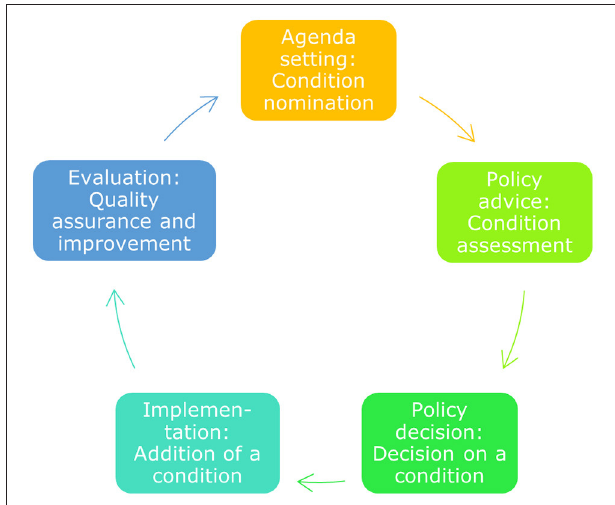
FIGURE 1 | The public health policy cycle. The public health policy cycle consists of five phases. These five phases translate to specific activities for NBS, from nomination of a condition to its quality assurance after implementation (